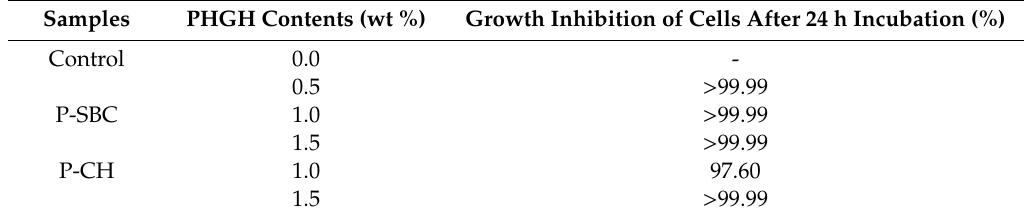
Table 1. Antimicrobial activity of modified fibers against E. coli